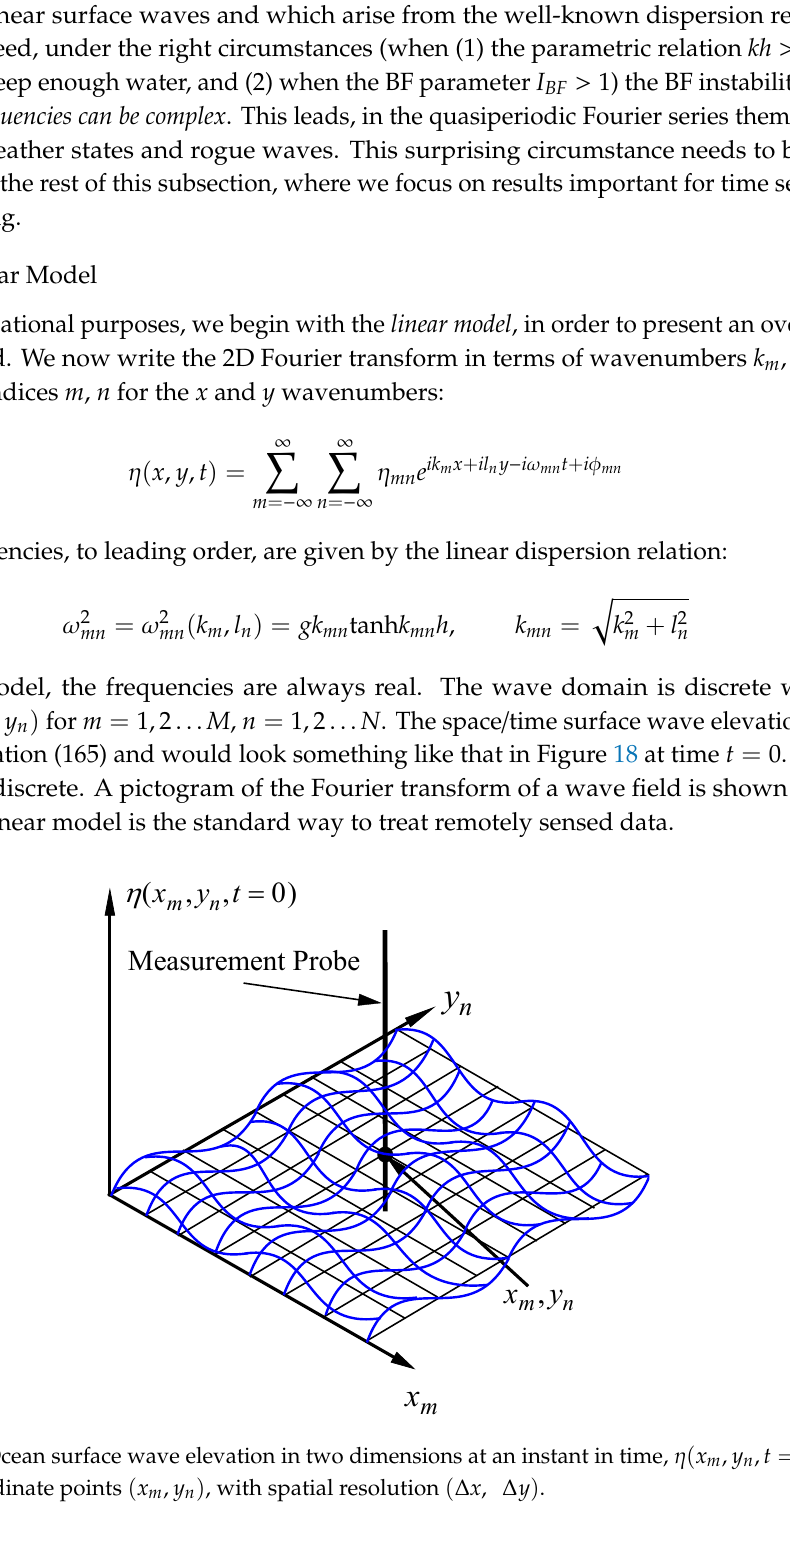
Figure 19. Two-dimensional ocean surface wave spectrum at an instant in time,  mn ( k m , l n , t  0) , on a commensurable wavenumber grid ( k m , l n ) with wavenumber resolution ( D k , D l ) . Thus, (168), together with (166) (or (170)), allows us to determine the directional spectrum, provided we use the incommensurable frequencies  mn . In the traditional analysis of time series, we use commensurable frequencies  i , which derives from 1 / T where T is the length of a measured time series: We do not here follow this tradition. We instead see that each point in a particular power